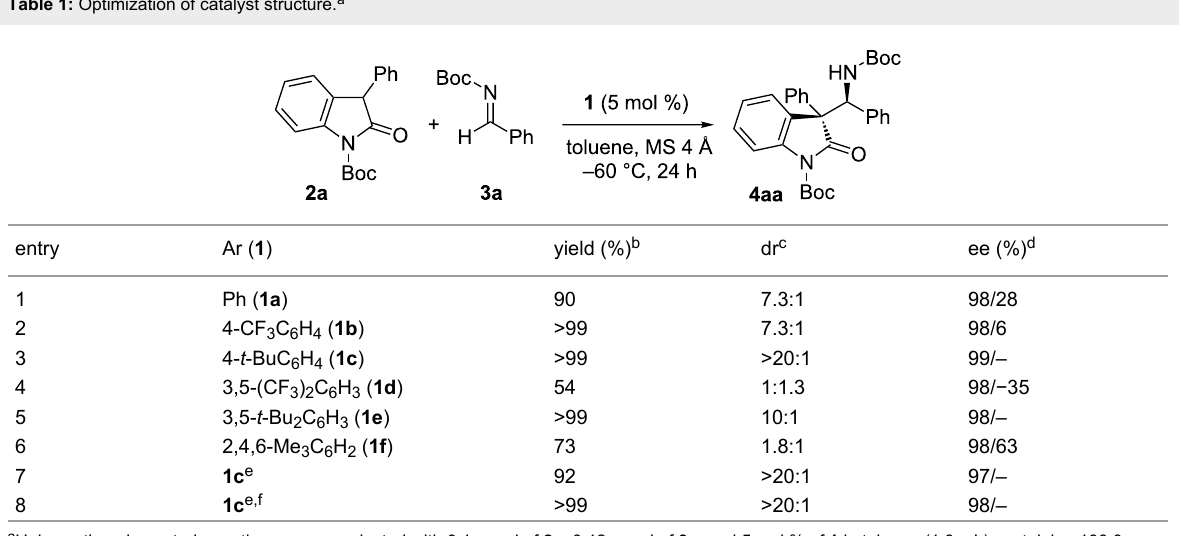
Table 1: Optimization of catalyst structure. a